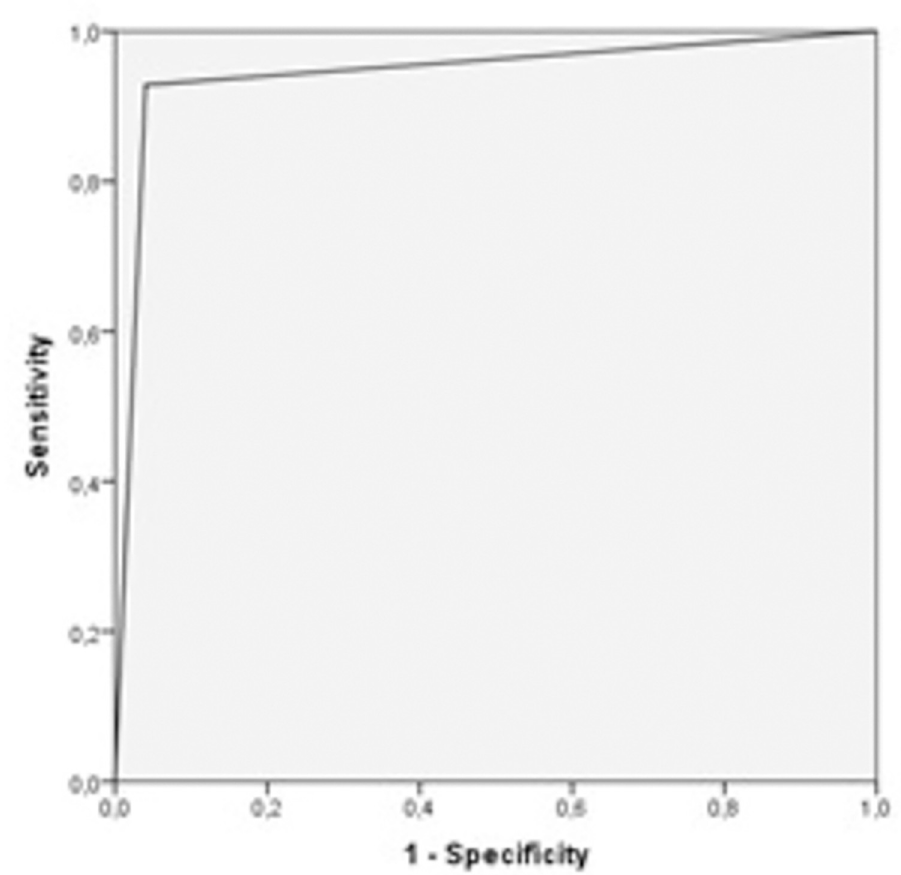
Fig 3. Full resource spectra for 48 mean positive samples and 48 negative samples. Light red and light blue colors represent the "distribution" of the sample, while dark colors are the average result. Light gray (not an additional graphic) shows the blend of color shades, representing the standard deviation of the 48 samples mean for positive and negative groups.